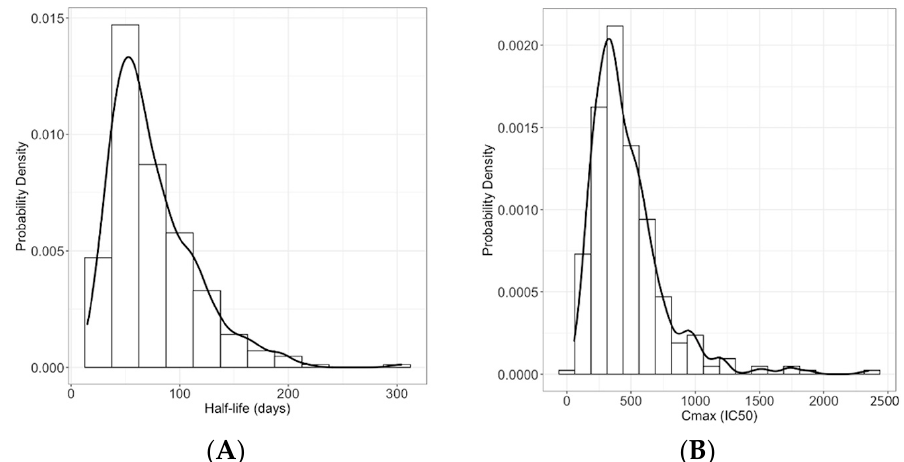
Figure 2. ( A ). Distribution of model-fitted individual nAb half-lives in the study population after vaccination. ( B ). Distribution of peak neutralizing titers after vaccination.